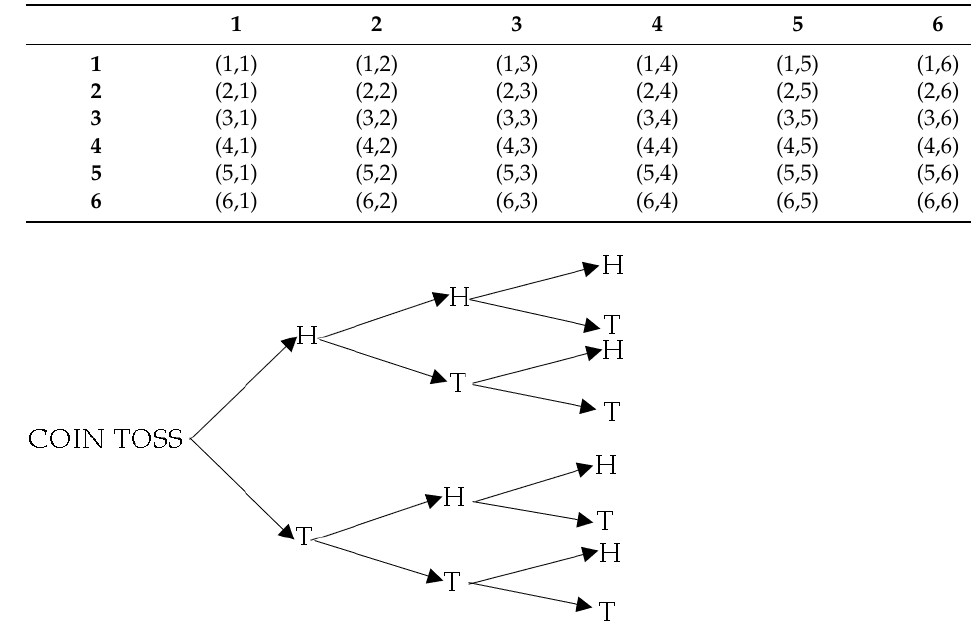
Figure 2. Graphical language for representing three coin tosses (binomial trial), where H = head and T = tails (adapted from [43]).